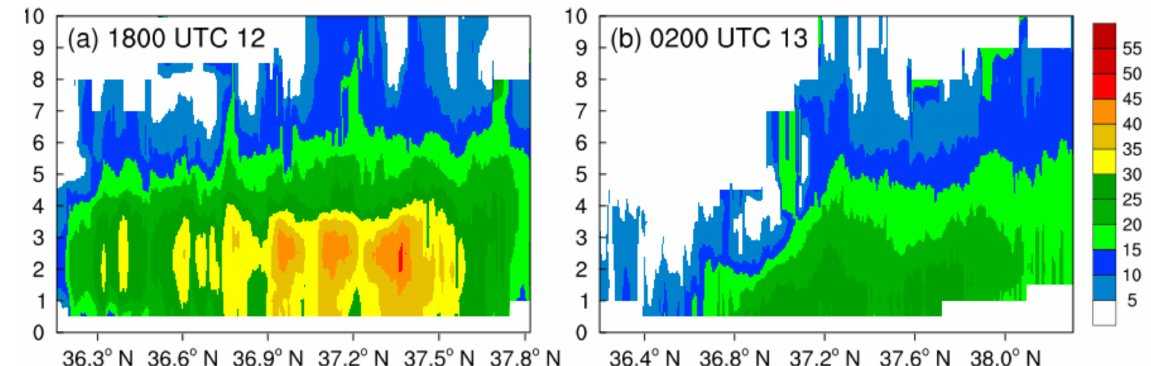
Figure 5. Vertical cross section of radar reflectivity (unit: dBZ) from the mosaic radar reflectivity data along ( a ) intense ERA (see Figure 4d) and ( b ) snowfall areas (see Figure 4h) at ( a ) 1800 UTC on 12 February and ( b ) 0200 UTC on 13 February 2016,